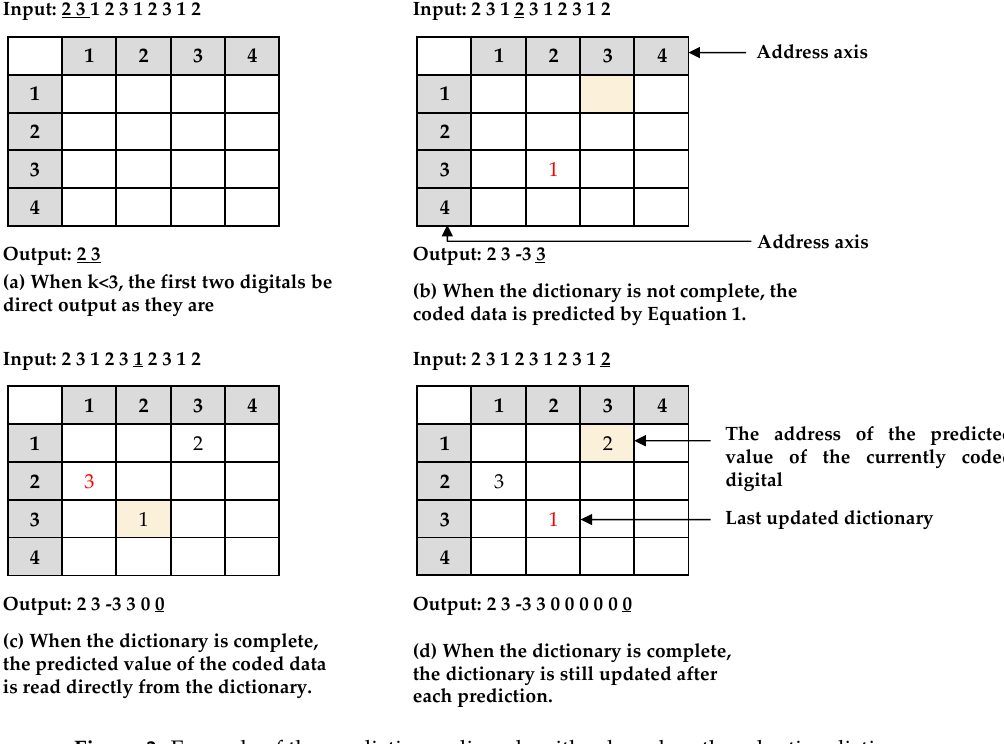
Figure 3. Example of the predictive coding algorithm based on the adaptive dictionary.